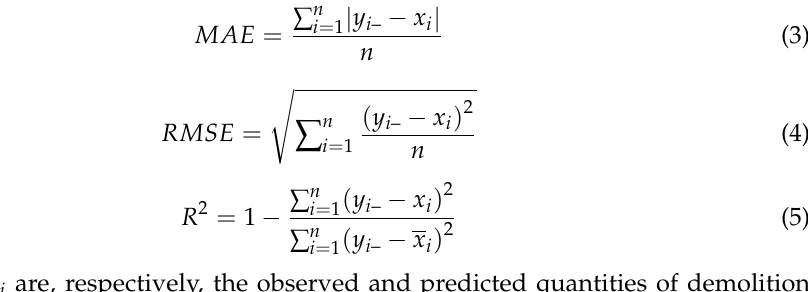
Figure 4. Decision tree model performance according to hyperparameter values (the minimum number of samples for each leaf [minimum samples leaf], split criteria, and maximum tree depth). The red diamond represents the hyperparameter value representing the optimal performance.